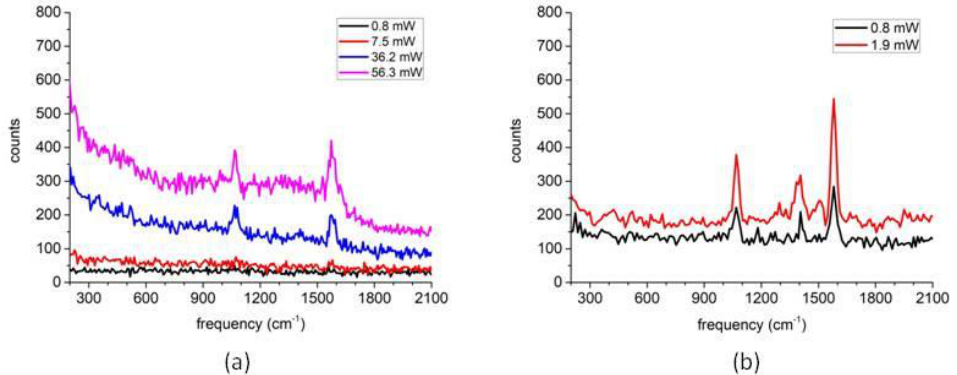
Figure 3. SERS spectra observed from the single nanoparticle and the dimer structure respectively correlating to Figure 2b,e at varying laser powers. ( a ) For the single nanoparticle; ( b ) for the dimer structure. The exposure times for the spectra in ( a , b ) were 3 s and 8 s, respectively.